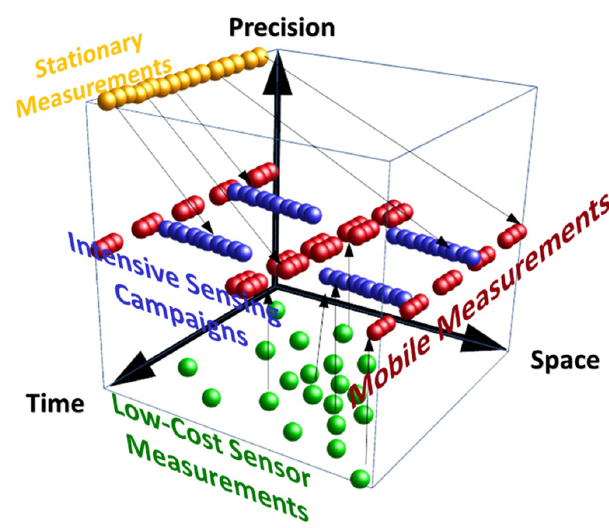
Figure 6. Configuration of ambient air measurements modelled as a space, time, and precision-dimensional feature space (large arrows): crowds with low-cost sensors (green) scatter irregularly in space and time at low precision but high number (source: Budde et al., 2017).